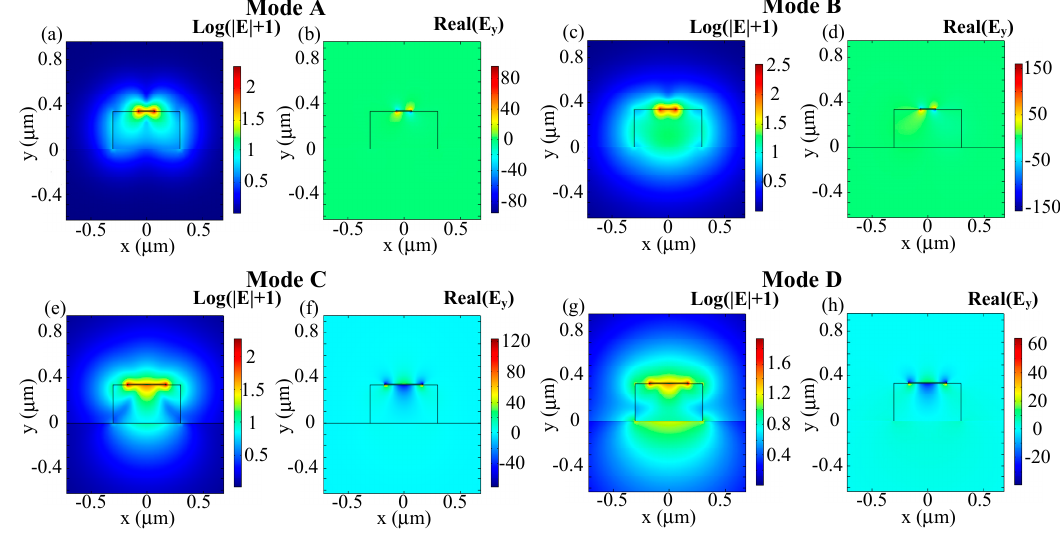
Figure 9. Electric field profiles of hybridized modes: ( a , b ) mode A and ( c , d ) mode B when w t = 0.14 µ m; ( e , f ) mode C and ( g , h ) mode D when w t = 0.34 µ m; ( a , c , e , g ) log( | E | + 1), ( b , d , f , h ) real (E y ). Other parameters: Au, h m = 7 nm, λ = 2 µ m, h si = 340 nm, w si = 600 nm.